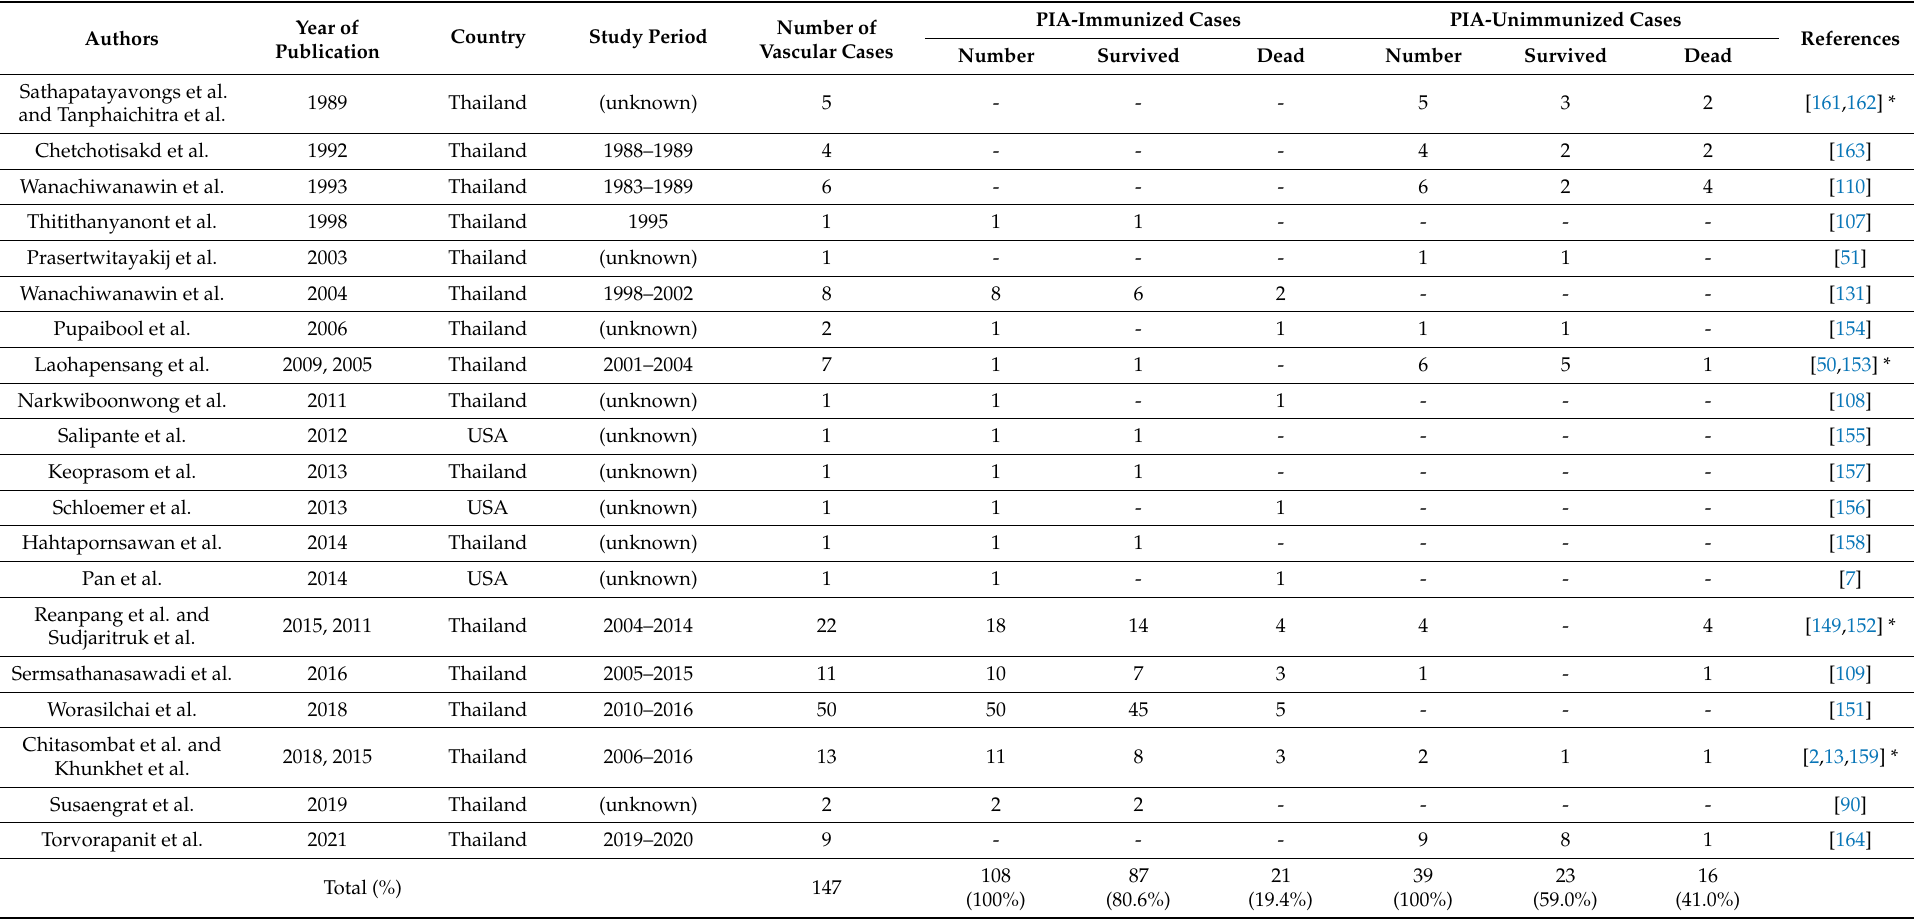
Table 1. Vascular pythiosis patients (147 cases) with or without the P. insidiosum antigen (PIA) immunotherapy, reported in the literature during